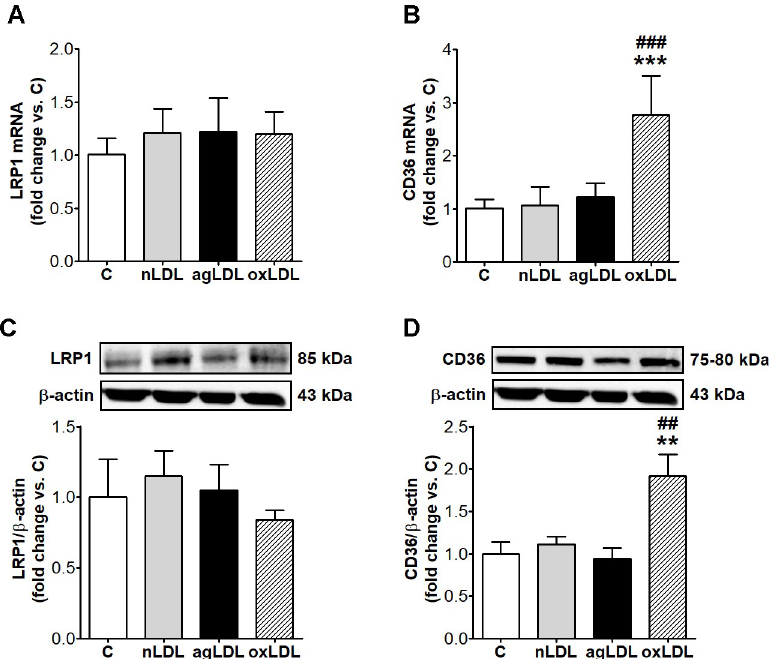
Fig 2. AgLDL do not modify LRP1 and CD36 expression in THP-1 macrophages. Cells were exposed for 24 h to 100 μ g/ml aggregated LDL (agLDL), oxidized LDL (oxLDL) or native LDL (nLDL). Cells incubated in the same conditions without LDL were considered control cells (C). mRNA levels of LRP1 (A) and CD36 (B) relative to β -actin (n = 6). Representative blot and densitometric analysis of LRP1 (C) and CD36 (D) protein normalized to β -actin (n = 4). All data are represented as fold change versus C and presented as mean ± SD. �� p < 0.01, ��� p < 0.001 vs. C; ## p < 0.01, ### p < 0.001 vs. nLDL.